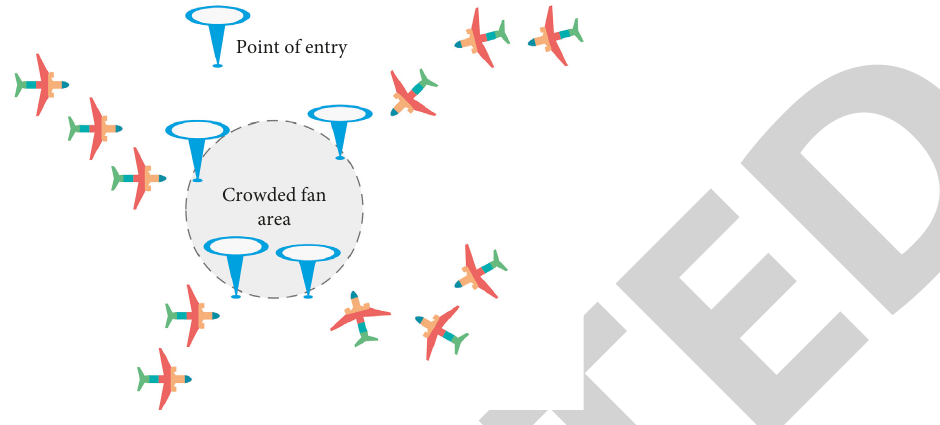
Figure 7: Types of airspace applicable to the central model.